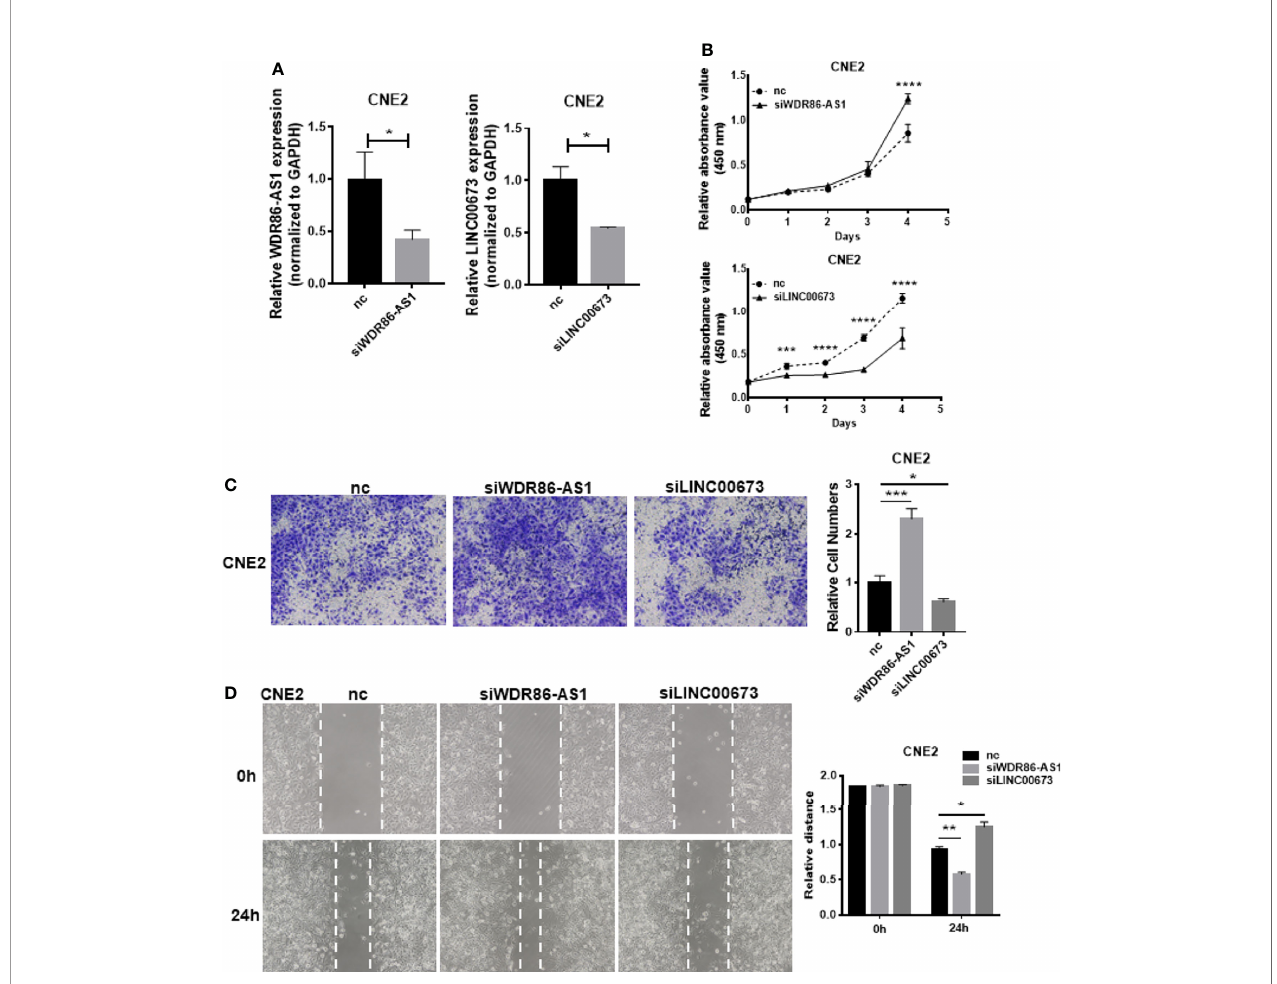
FIGURE 3 | Biological function of differentially expressed lncRNAs. (A) The ef fi ciency of knock down was detected by qPCR. (B) CCK8 was used to measure the proliferation ability of lncRNAs. (C) Transwell assays were performed to detect the invasion potential of lncRNAs after knock down. (D) Wound healing assays were employed to assess the migration rate. * means p<0.05, ** means p<0.01, *** means p<0.001, **** means